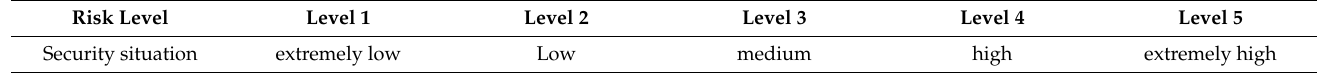
Table 1. Bridge safety state level classification.